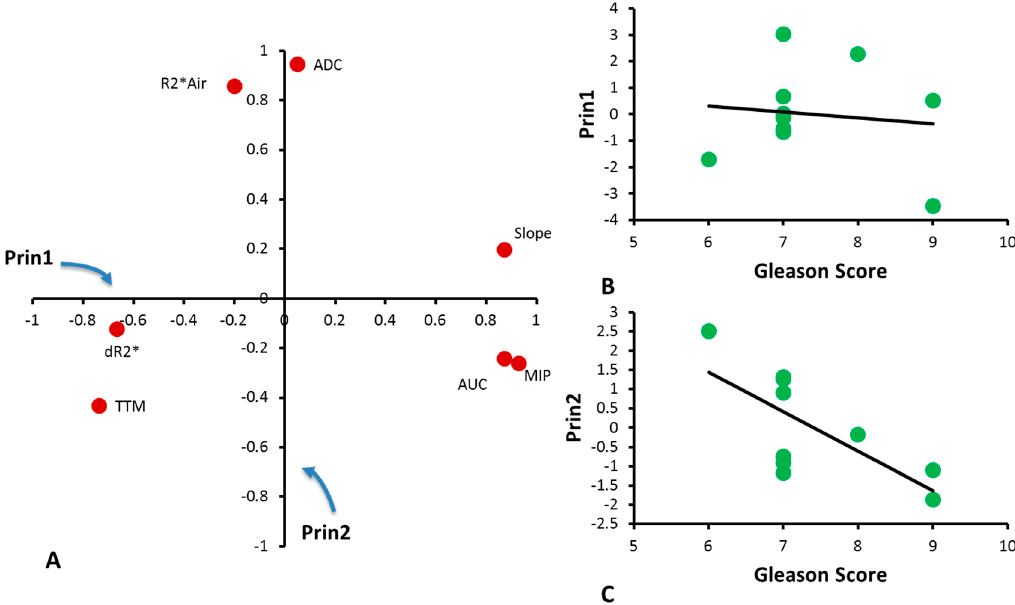
Figure 6. Principal Component Analysis. ( A ) Loadings of MRI parameters with Principal Components 1 and 2 describing the contribution of MRI parameters to Principal Components; ( B ) Correlation between Principal Component 1 and Gleason Score for individual tumors ( R 2 = 0.02; p = 0.72); ( C ) Correlation between Principal Component 2 and Gleason Score for individual tumors ( R 2 = 0.49; p < 0.05).